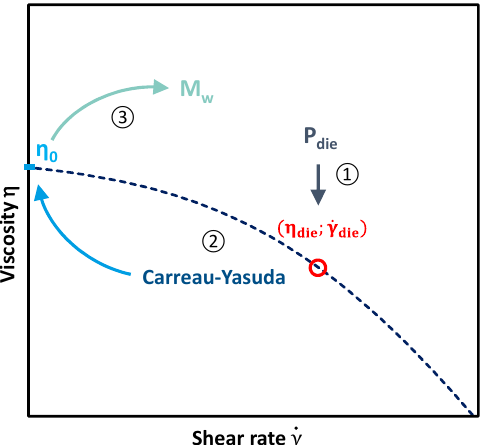
Figure 4. Scheme of the Mw determination from die pressure measurement.